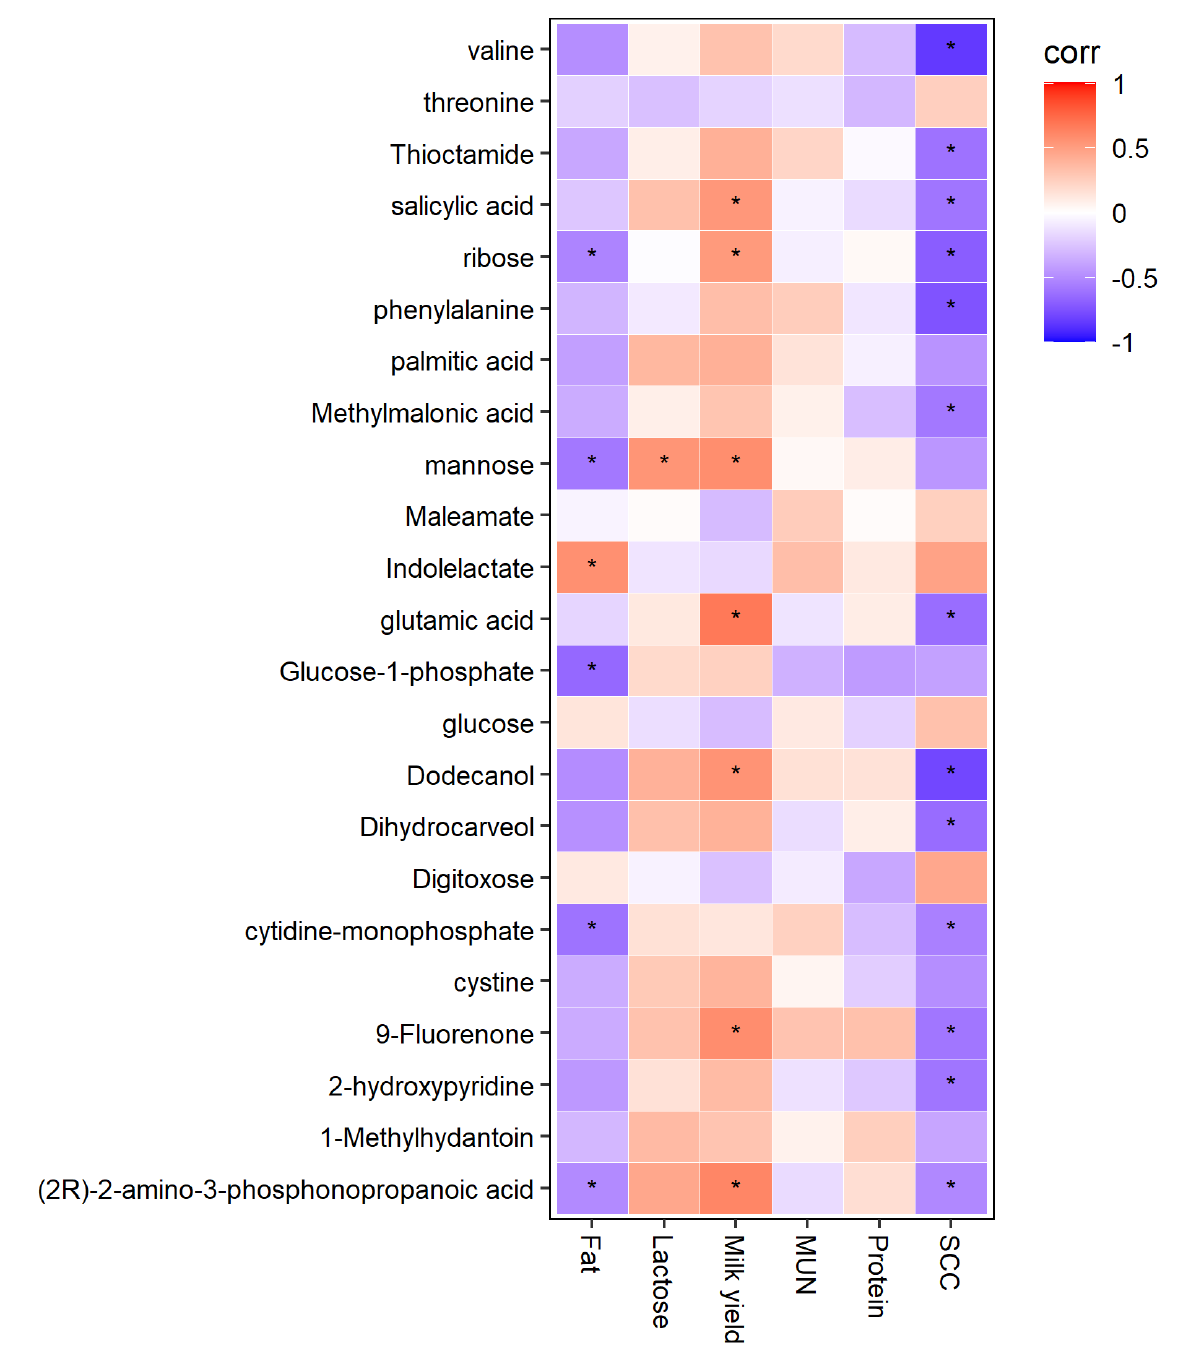
Figure 4. Correlation analyses between the lactation performance and plasma differential metabolites. The red squares represent the positive correlations while the blue ones represent the negative correlations. * p<0.05. MUN, milk urea nitrogen; SCC, somatic cell